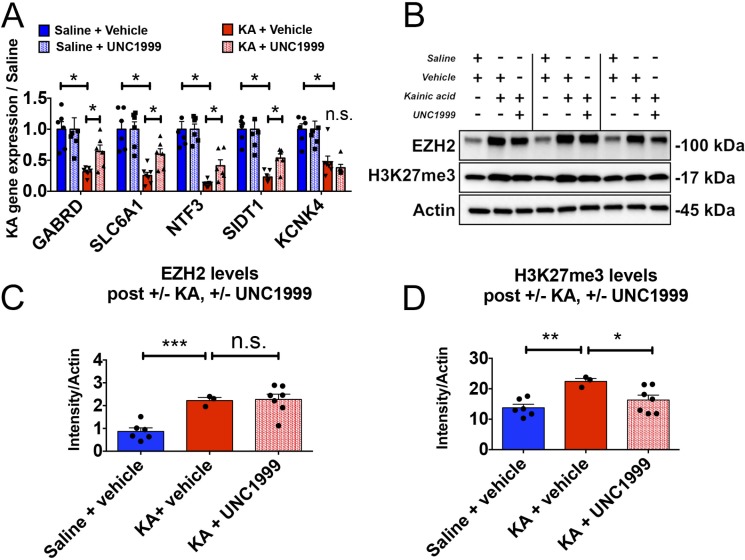
UNC1999 treatment three days in vivo is sufficient cause functional changes in EZH2 target gene expression and H3K27me3 levels.(A) Schematic demonstrating how tissue was harvested to assess EZH2 target gene expression levels post UNC1999 treatment. B) Expression levels of EZH2 target genes are de-repressed after treatment with UNC1999 (multiple t-tests, p <0.05, with Holm-Sidak correction). (C) EZH2 protein levels do not change eight days after UNC1999 treatment. (D) Increased H3K27me3 levels detected at 10 days in KA + vehicle treated animals are reduced with treatment of UNC1999. Statistical significance assessed by Student’s unpaired t-test with equal SD (p < 0.05), n = 6 saline + vehicle, n = 3 KA + vehicle and n = 7 KA + UNC1999 animals. *p <0.05, **p < 0.01, ***p< 0.001, ****p <0.0001.